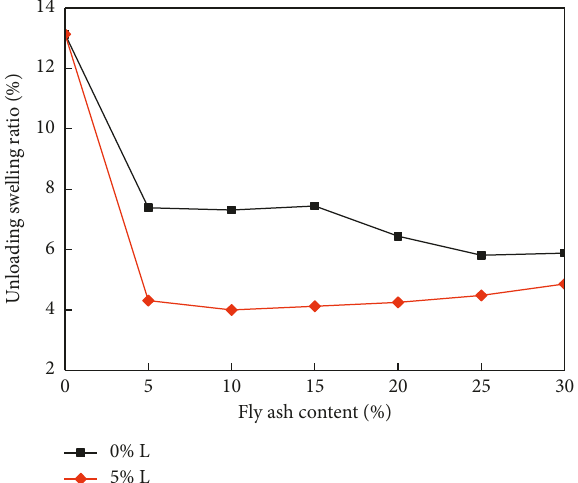
Figure 6: Variation laws of unloading swelling ratio under dif- ferent fly ash and lime contents.